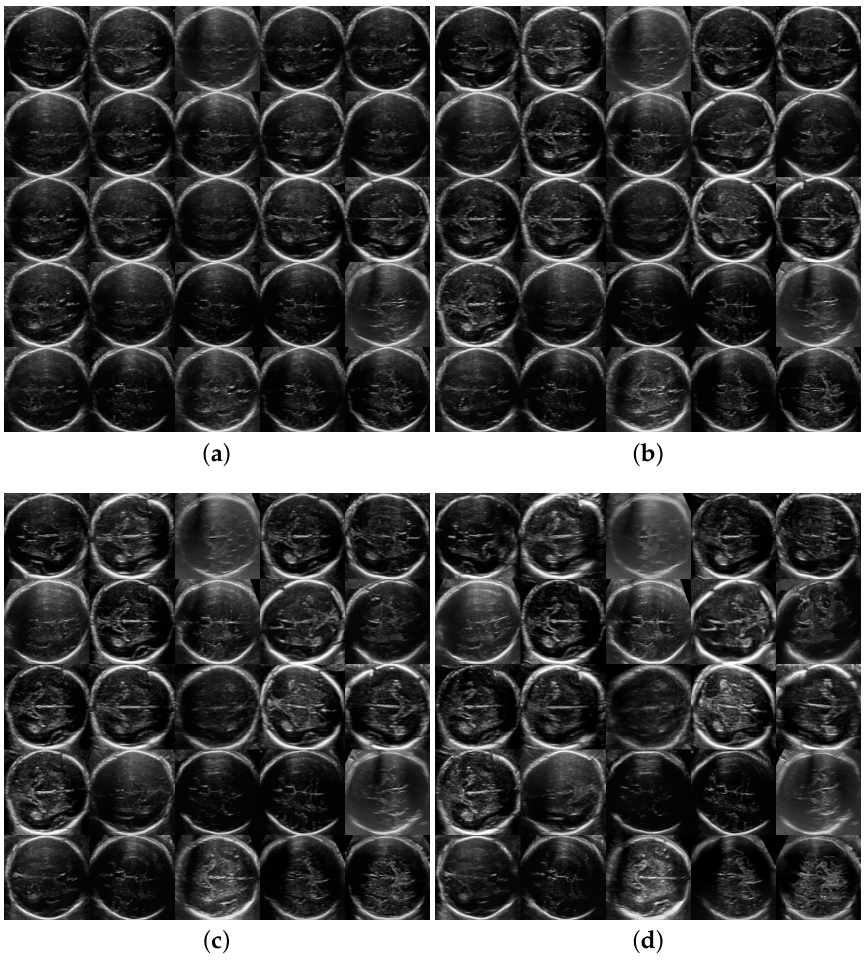
Figure 2. Generation of Trans-thalamic images for some random seeds and different ψ . Same 25 seeds were applied to each grid giving the same 25 brain plane generation for three ψ values and no truncation. ( a ) ψ = 0.3; ( b ) ψ = 0.5; ( c ) ψ = 0.7; ( d ) ψ = 1 (no truncation).